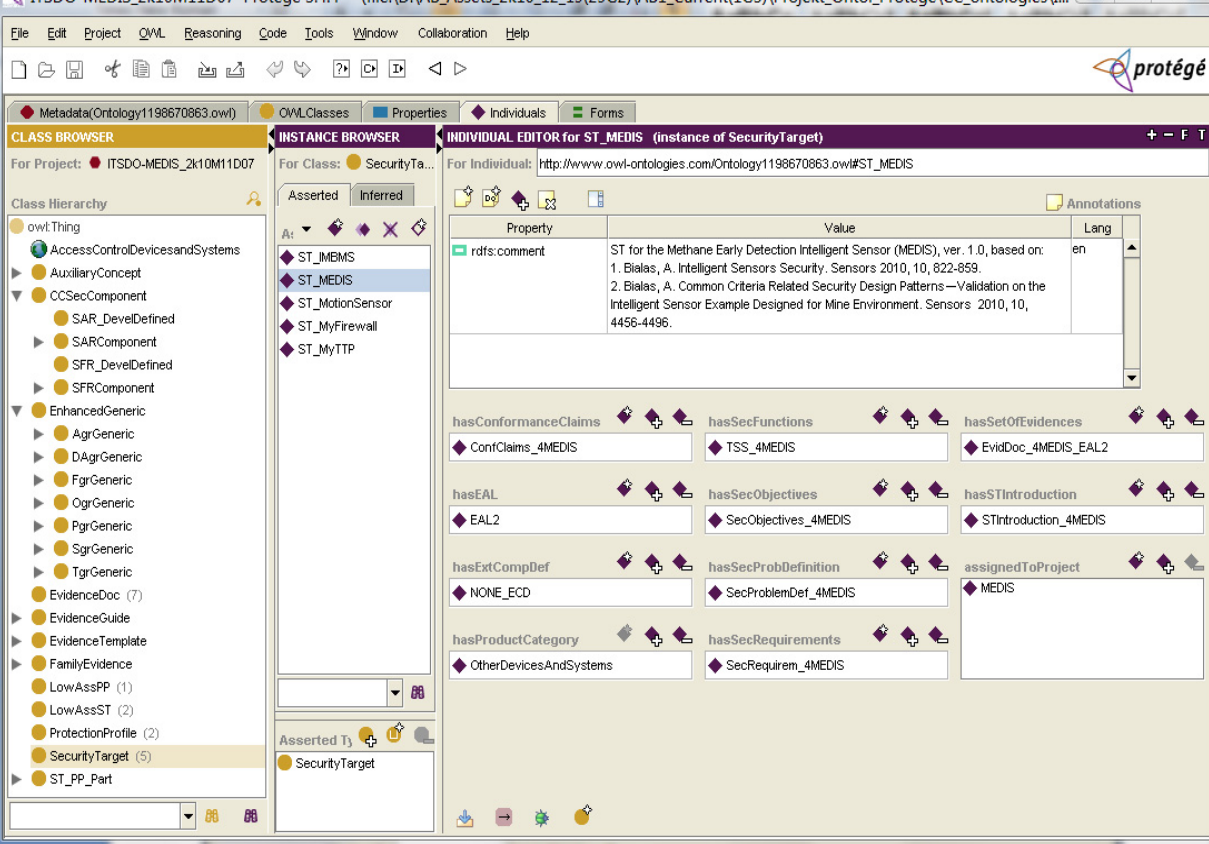
Figure 2. The MEDIS security target viewed in the Protégé tool